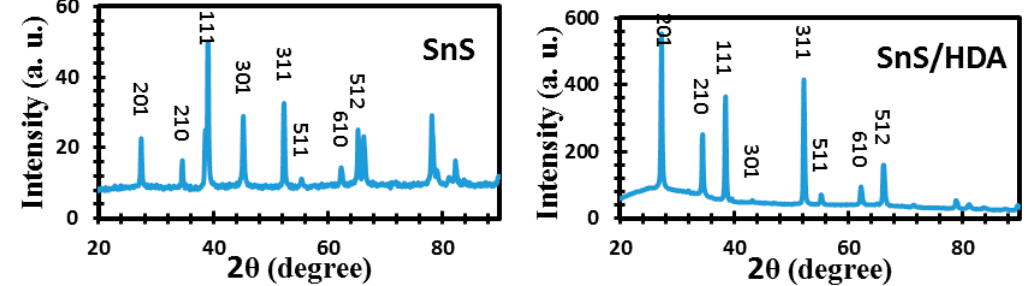
Figure 5. XRD spectra of SnS/HDA and SnS nanoparticles.